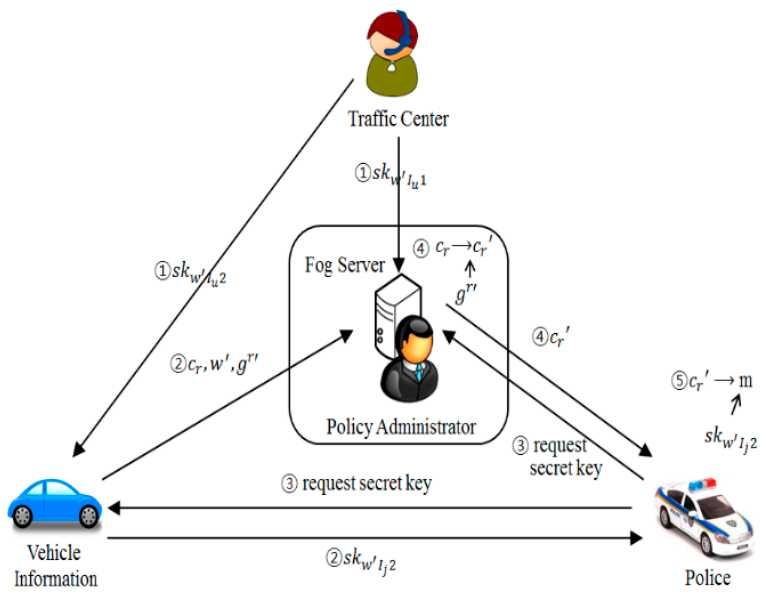
Figure 6. The configuration of the scenario.